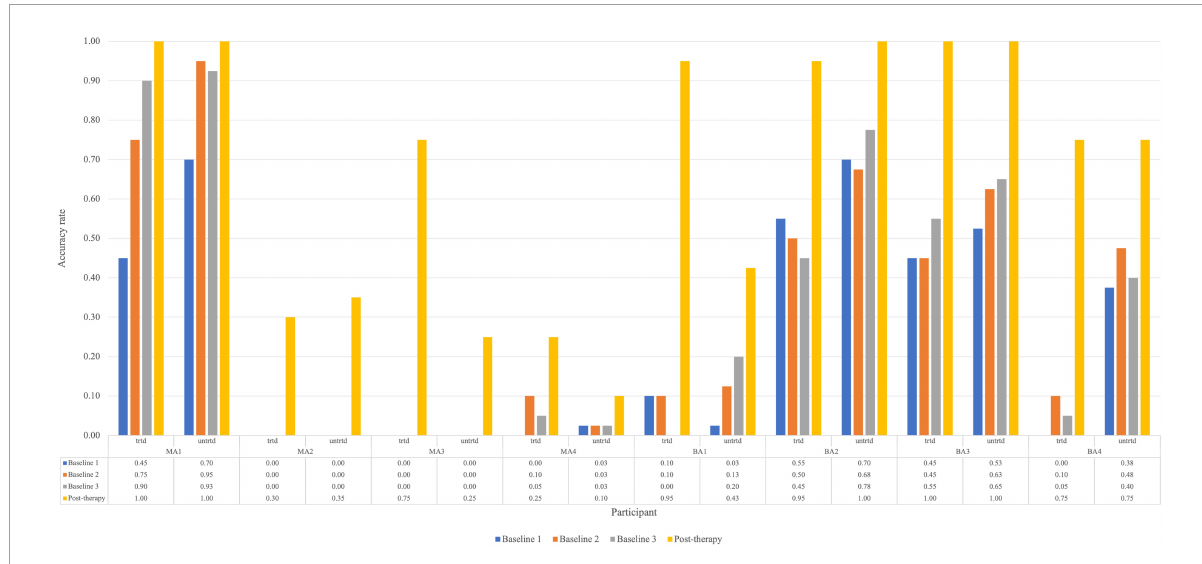
FIGURE3 Accuracy rate for each participant for treated and untreated items at each picture-naming probe. Trtd, treated items (20) and untrtd, untreated items